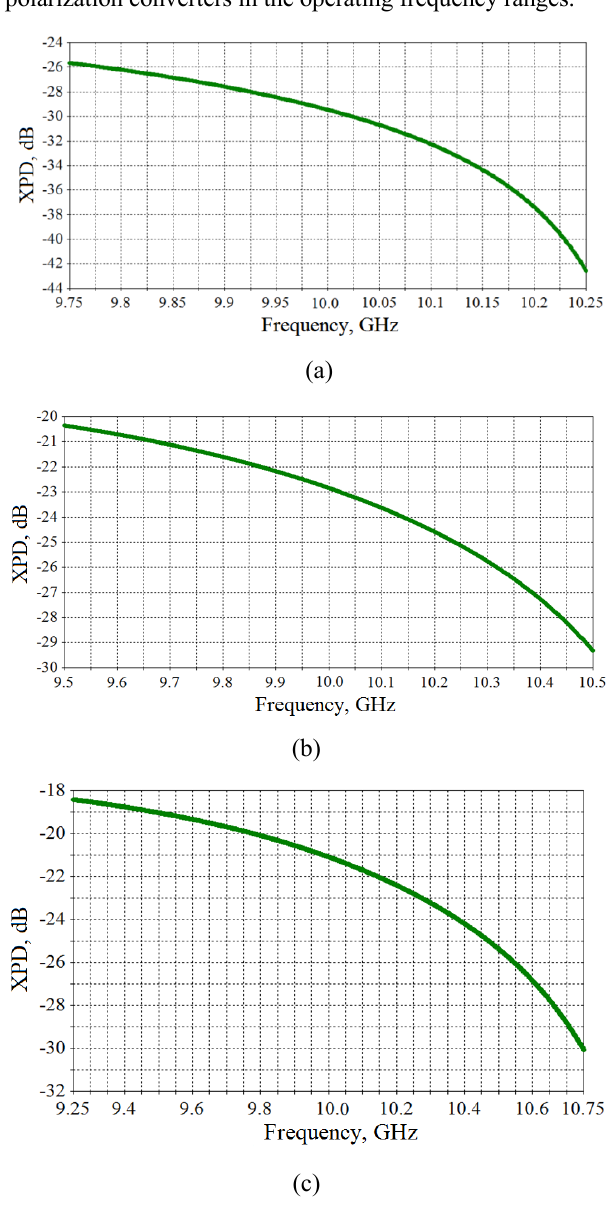
FIGURE 6. Dependences of cross-polarization discriminations of a 2-step septulum polarizer on frequency for different relative bandwidths: (a) 5% relative bandwidth; (b) 10% relative bandwidth; (c) 15% relative bandwidth. Fig. 6a shows that the cross-polarization discrimination is higher than 26 dB in the 5% operating band with center frequency of 10 GHz. The peak value occurs at the frequency of 9.75 GHz. Fig. 6b demonstrates that the cross-polarization discrimination is greater than 20.4 dB in the 10% operating frequency band with center frequency of 10 GHz. It can be seen in Fig. 6c that the extreme cross-polarization value of 18.5 dB is observed at the frequency of 9.25 GHz for the 15% operating band with center frequency of 10